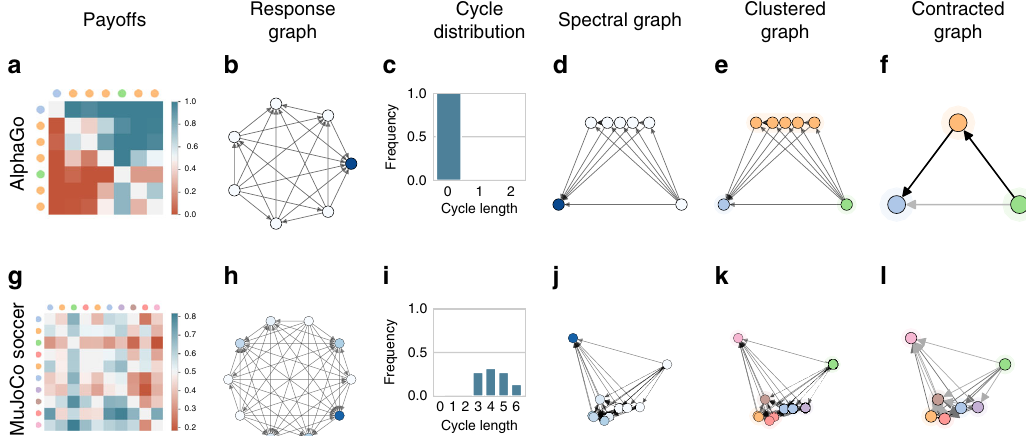
Fig. 6 Results for empirical games of AlphaGo and MuJoCo soccer dataset. Note that as these are empirical games, strategies here correspond to trained AI agents. In AlphaGo, the strong transitive relationship between agents is revealed via our analysis. In MuJoCo soccer, more complex relations between similarly-performing agents are revealed in the clusters Table 9). The α -Rank distribution indicated by the node (i.e., Fig. 5g, relabeled to match cluster colors, demonstrates that our technique effectively pinpoints the sets of strategies that de fi ne the rules of the game: weak strategies (11 or 12 units, fi rst two rows of the payoff table, and evident in the far-right of the clustered response graph), followed by a set of intermediate strategies with higher payoffs (clustered pairwise, near the lower- center of the clustered response graph), and fi nally the two key strategies that establish the cyclical relationship within the game through k -level reasoning (19 and 20 units, corresponding to level-0 and level-1 players, in the far-left of the clustered response graph).